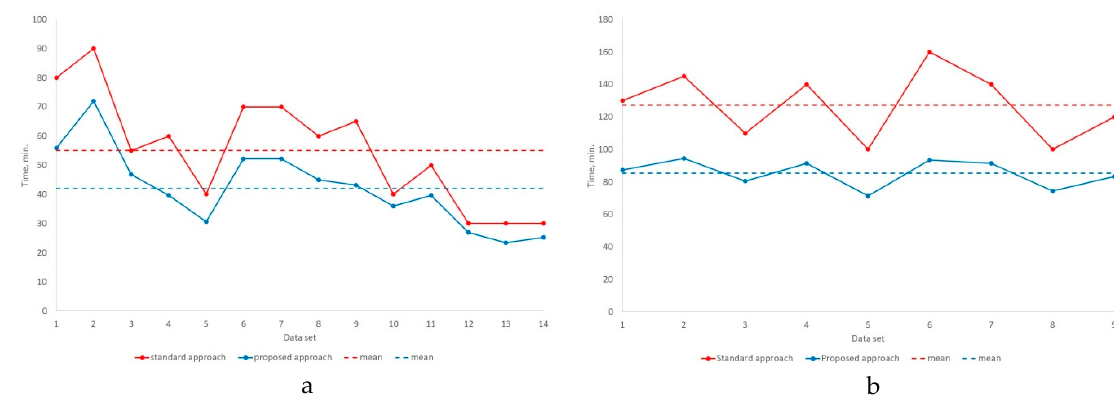
Figure 7. Measurement results of the runtime of the initial data validation by experts in the task of: ( a ) reserve calculation; ( b ) development forecast